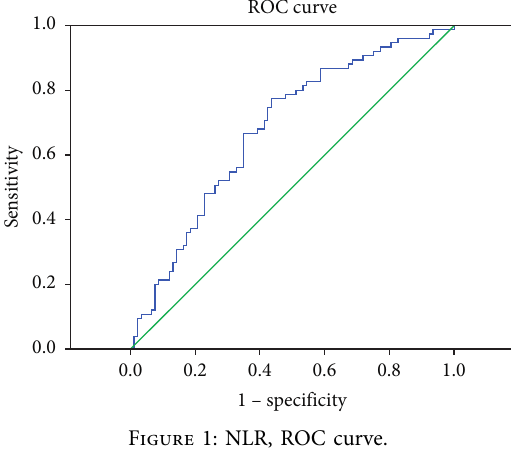
Figure 1: NLR, ROC curve.